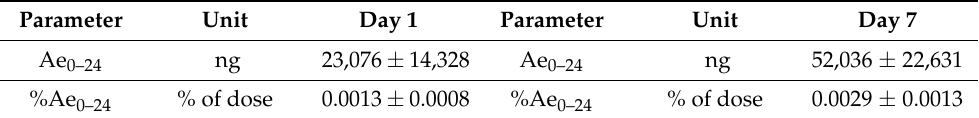
Table 6. Total amount of rifamycin SV excreted in urine calculated on Days 1 and 7 of the treatment; mean ± SD is reported. N = 18.